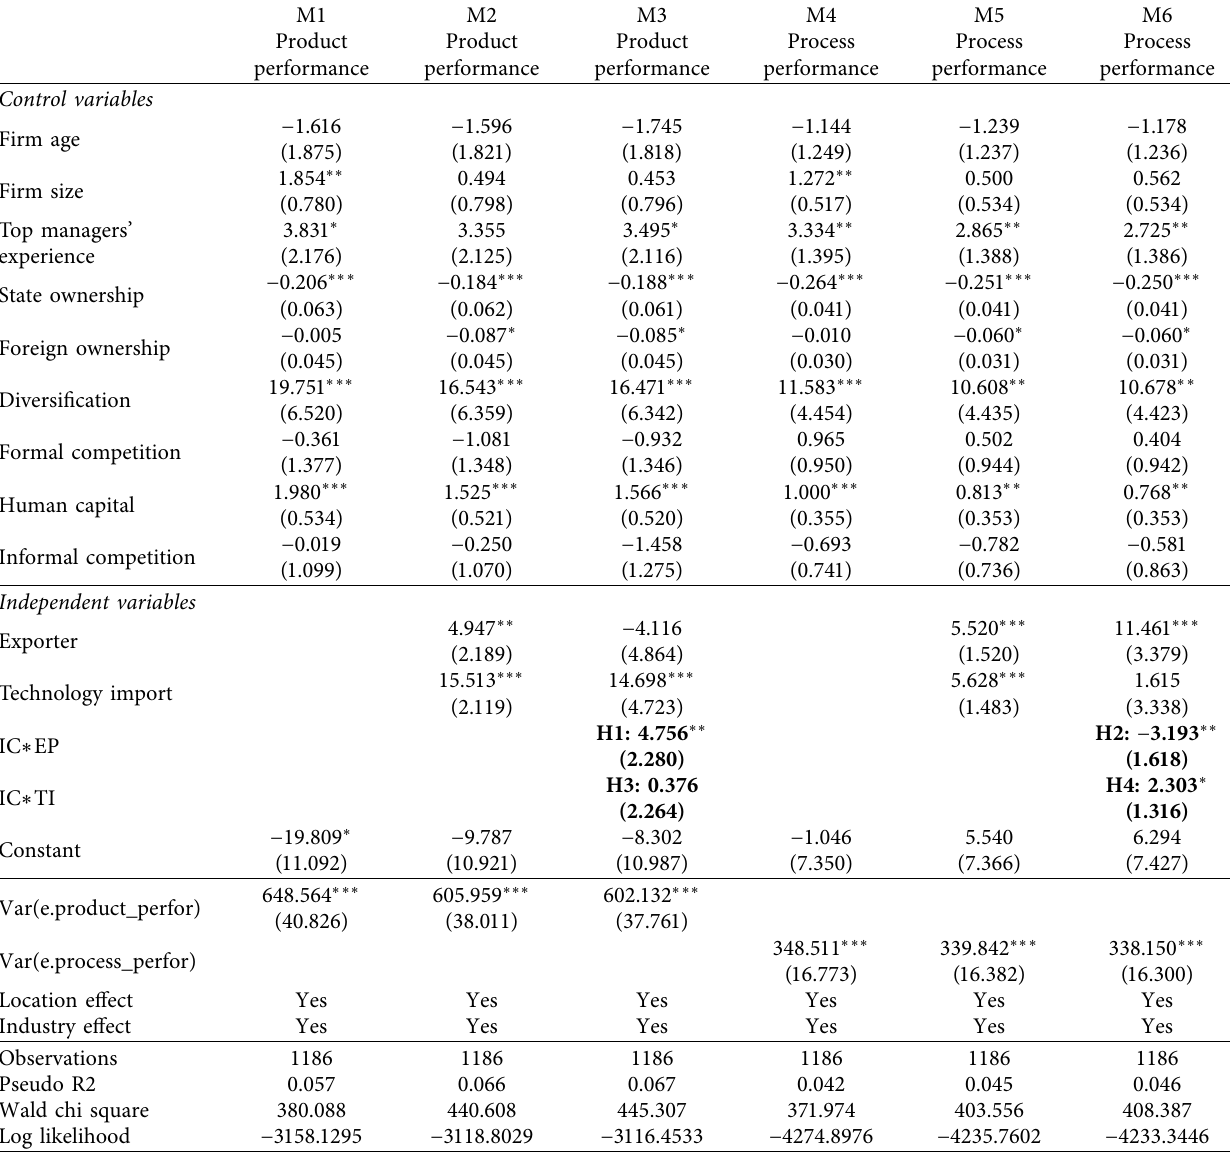
Table 5: Tobit regressions results for product/process innovation performance (continuous